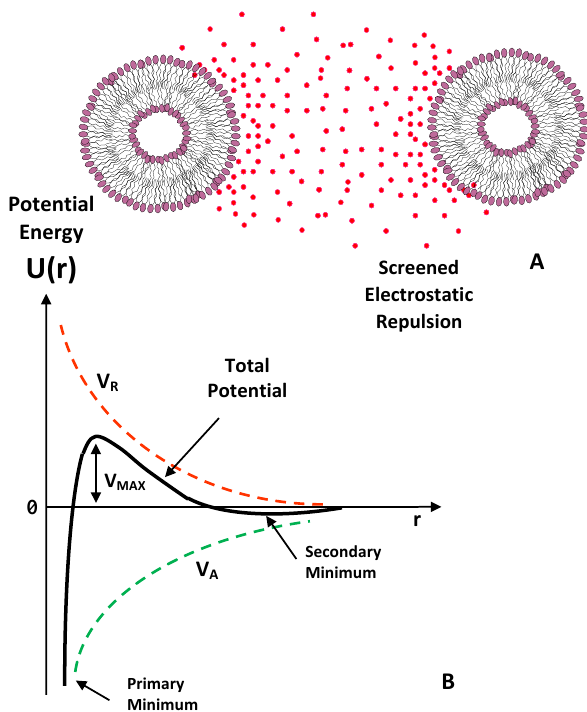
Figure 5. Sketch of the Derjaguin–Landau–Verwey–Overbeek (DLVO)-type interaction energy as a function of particle separation. The net energy is given by the sum of the double layer repulsion V R represented by a Yukawa type potential (electrostatic repulsion screened by ionic species in solution) and the Van der Waals attractive forces potential V A .